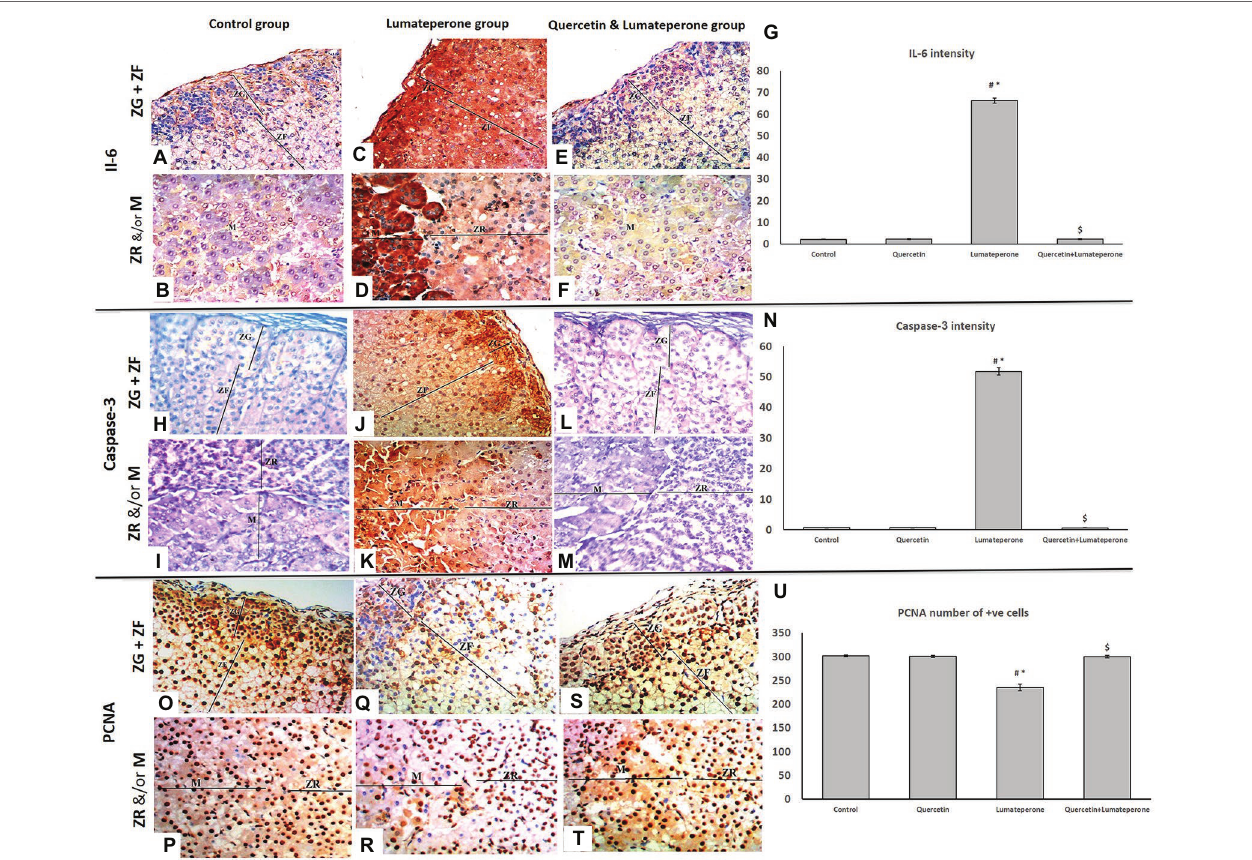
FIGURE 5 | Adrenal immune histochemistry. (A) A section of group I (control) showing mild cytoplasmic reaction for IL-6 of adrenal cortical cells of both ZG and ZF (IL-6×200). (B) A section of group I (control) showing mild cytoplasmic reaction for IL-6 of adrenal cells of both ZR and medulla (IL- 6×200). (C) Group III (lumateperone) showing extensive cytoplasmic reaction for IL-6 of adrenal cortical cells of ZG and the strong cytoplasmic reaction of ZF (IL-6×200). (D) Group III (lumateperone) showing mild cytoplasmic reaction for IL-6 of adrenal cortical cells of ZR and the strong cytoplasmic reaction of the medulla (IL-6×200). (E) Group IV (quercetin + lumateperone) showing mild cytoplasmic reactions for IL-6 of adrenal cortical cells of both ZG and ZF (IL-6×200). (F) Group IV (quercetin + lumateperone) showing mild cytoplasmic reaction for IL-6 of adrenal medulla (IL-6×200). (G) IL-6 intensity among groups analyzed by morphometry (H) Group I (control) showing negative cytoplasmic reactions for caspase-3 of adrenal cortical cells of both ZG and ZF (Caspase-3×200). (I) A section of group I (control) showing negative cytoplasmic reaction for caspase-3 of adrenal cortical cells of both ZR and medulla (caspase-3×200). (J) Group III (lumateperone) showing extensive cytoplasmic reaction for caspase-3 of adrenal cortical cells of ZG and moderate cytoplasmic reactions of ZF (caspase-3×200). (K) Group III (lumateperone) showing mild cytoplasmic reactions for caspase-3 of adrenal cortical cells of ZR and the strong cytoplasmic reaction of the medulla (caspase-3×200). (L) Group IV (quercetin + lumateperone) showing negative cytoplasmic reaction for caspase-3 of adrenal cortical cells of both ZG and ZF (caspase-3×200). (M) A section of group IV (quercetin + lumateperone) showing negative cytoplasmic reaction for caspase-3 of adrenal cortical cells of both ZR and medulla (caspase-3×200). (N) Caspase-3 intensity among groups analyzed by morphometry. (O) A PCNA stained section of group I, showing the positive nuclear reaction of most cells of adrenal cortical cells of both ZG (arrow) and ZF (arrowhead; PCNA ×200). (P) Group I, showing PCNA-positive nuclear reaction of adrenal cells of both ZR (arrowhead) and medulla (arrow; M; PCNA ×200). (Q) A section of PCNA stained section of group III (lumateperone) showing the negative nuclear reactions of many cells of adrenal cortical cells of both ZG (arrow) and ZF (arrowhead; PCNA ×200). (R) Group III (lumateperone) showing PCNA-negative nuclear reaction of adrenal cells of both ZR (arrowhead) and medulla (arrowhead; PCNA ×200). (S) A PCNA stained section of group IV (quercetin + lumateperone) showing a positive nuclear reaction of most cells of adrenal cortical cells of both ZG (arrow) and ZF (arrowhead; PCNA ×200). (T) Group IV (quercetin + lumateperone) showing PCNA-positive nuclear reaction of adrenal cells of both ZR (arrowhead) and medulla (arrow; PCNA ×200). (U) PCNA number of +ve cells among groups analyzed by morphometry. Data of morphometry were expressed as mean ± SD ( n = 10). One-way ANOVA: # < 0.05 vs. control; ∗ < 0.05 vs. quercetin; $ < 0.05 vs. lumateperone. N.B. Control with quercetin group showed the same findings as the control